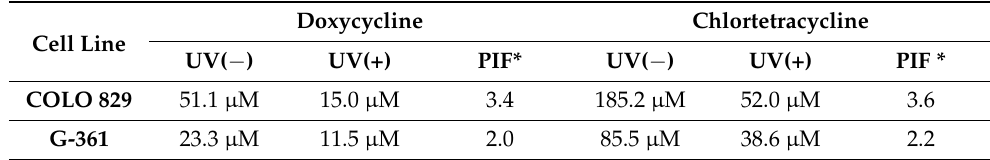
Table 2. The analysis of the cell cycle presented as a relative ratio of G 1 /S and G 2 -M/S for COLO 829 and G-361 melanoma cells treated with DOX and CHL and exposed to UVA radiation.